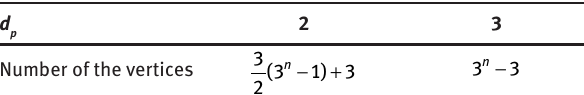
Table 4: Vertex partition of vertex set of SD ( S ( n , C